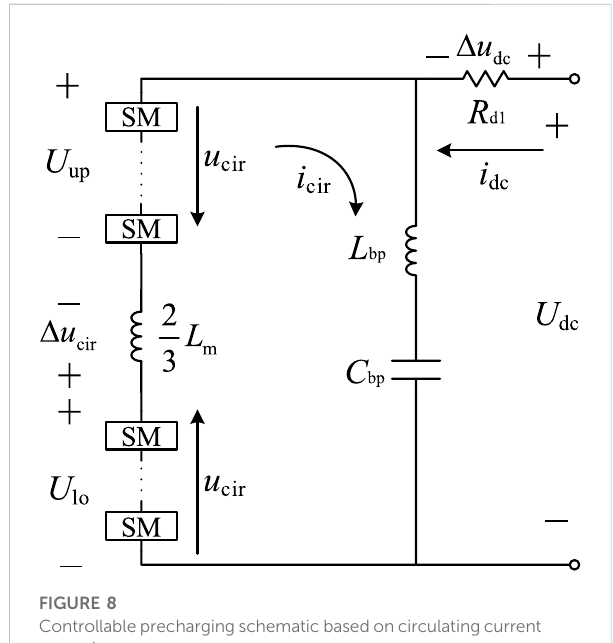
FIGURE 8 Controllableprechargingschematic basedoncirculatingcurrent